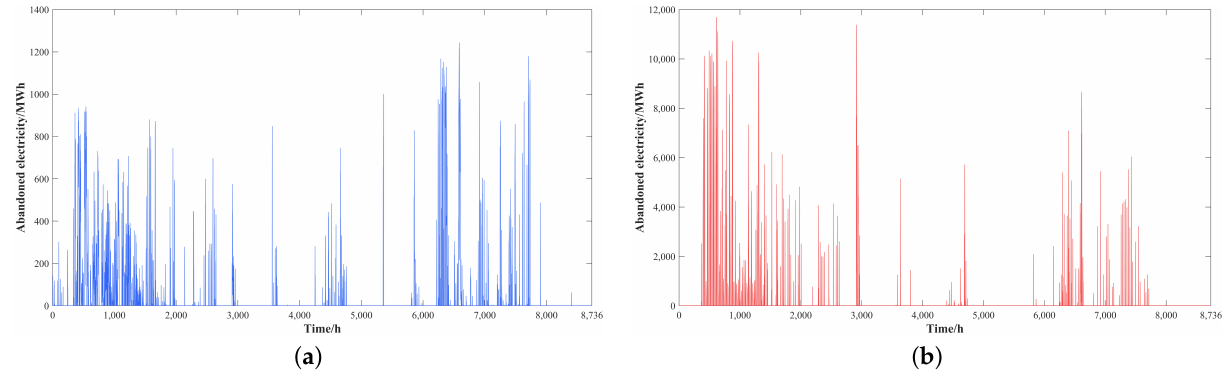
Figure 10. Full-time curtailment curve of renewable energy in Case A. ( a ) The curve of wind-power curtailment. ( b ) The curve of PV power curtailment.